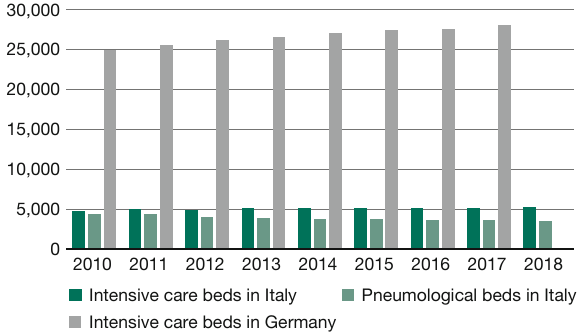
Total number of intensive care beds